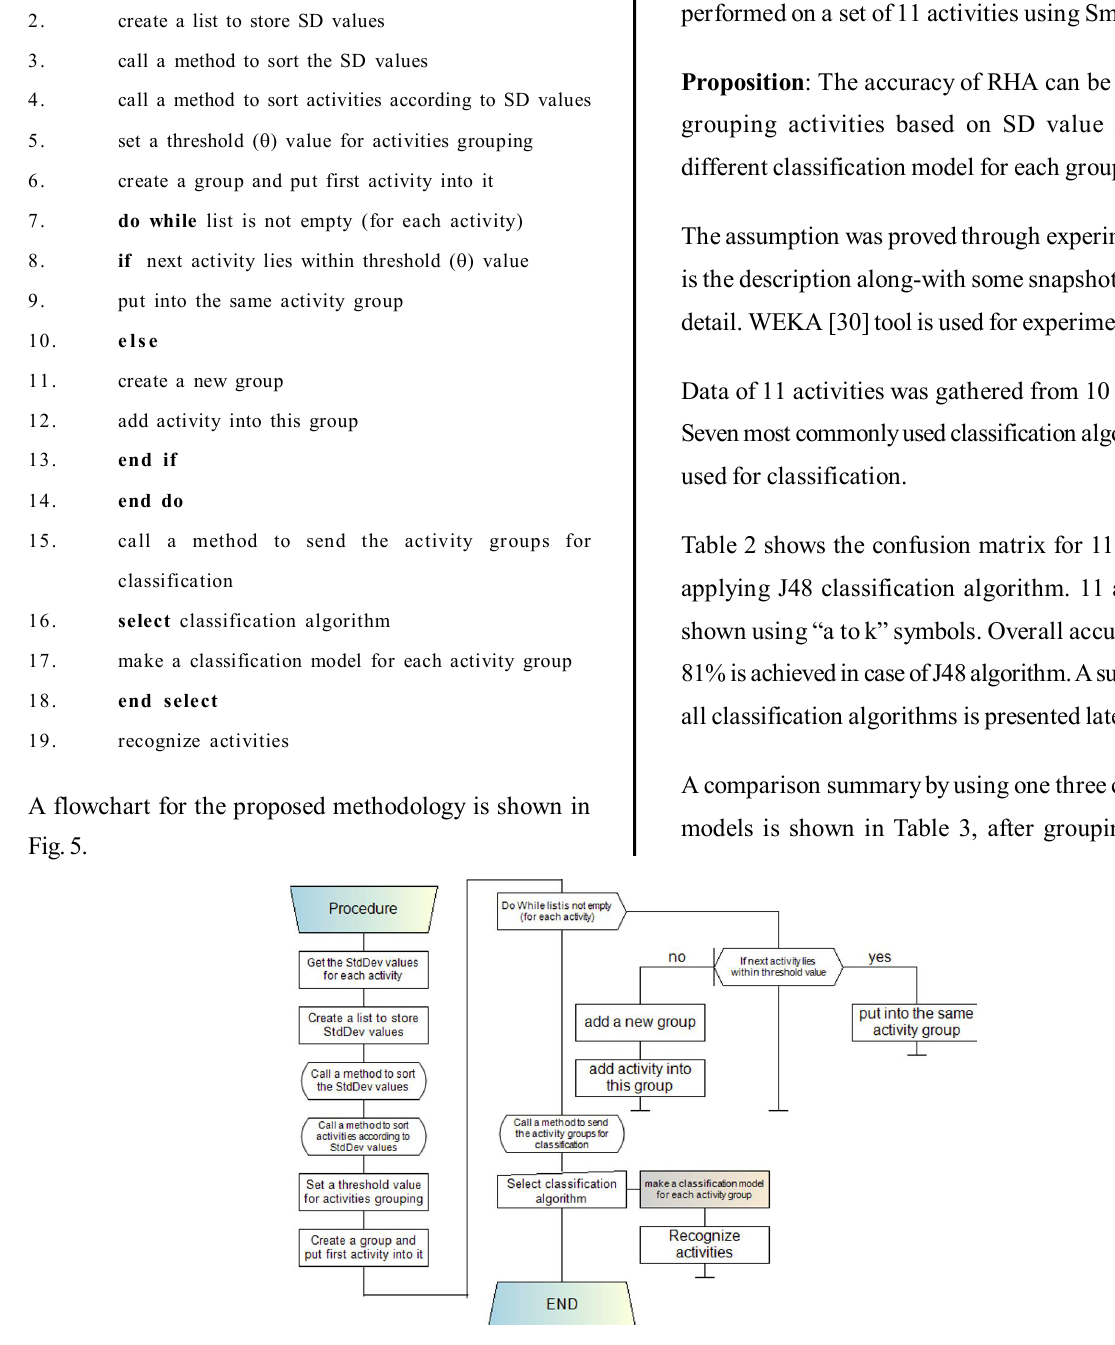
FIG. 5. PROPOSED METHODOLOGY, A